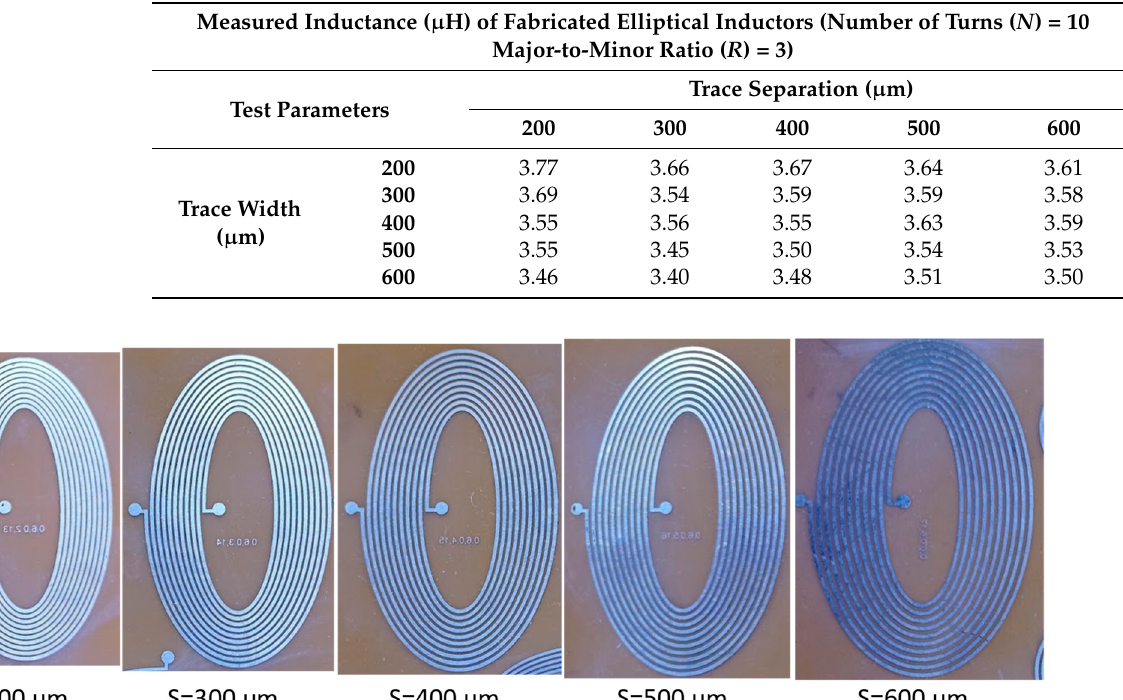
Table 3. Measured inductances of elliptical planar inductors for different combinations of trace separation ( S ) and trace width ( W ) while major-to-minor ratio ( R ) = 3 and number of turns ( N ) = 10.